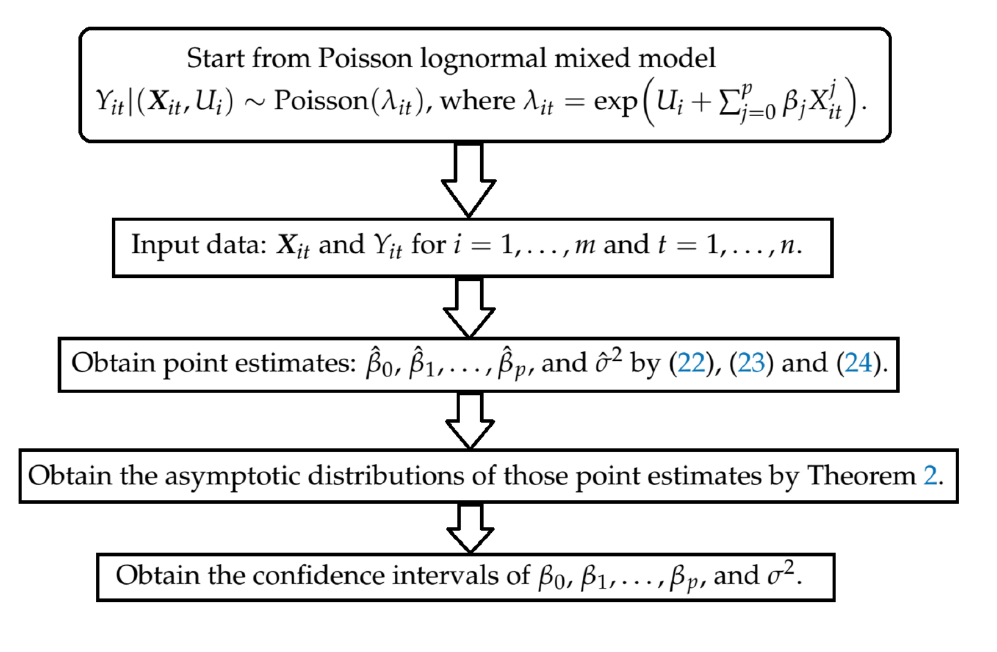
Figure 6. Flowchart of the proposed algorithm using